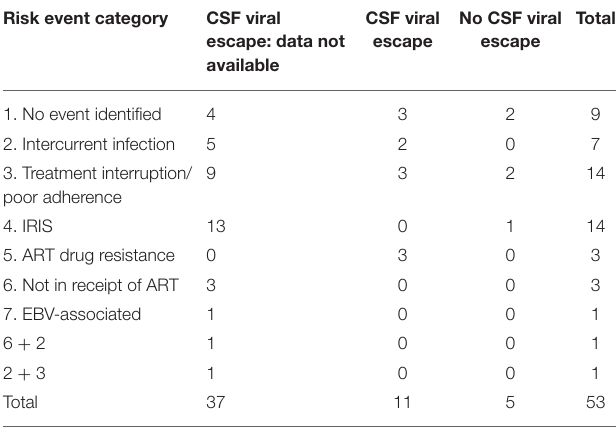
TABLE 3 | Patients with pathologically proven HIV-CD8 encephalitis: risk event categories and CSF viral escape; summary data from UK 23 cases and from 30 global previously published